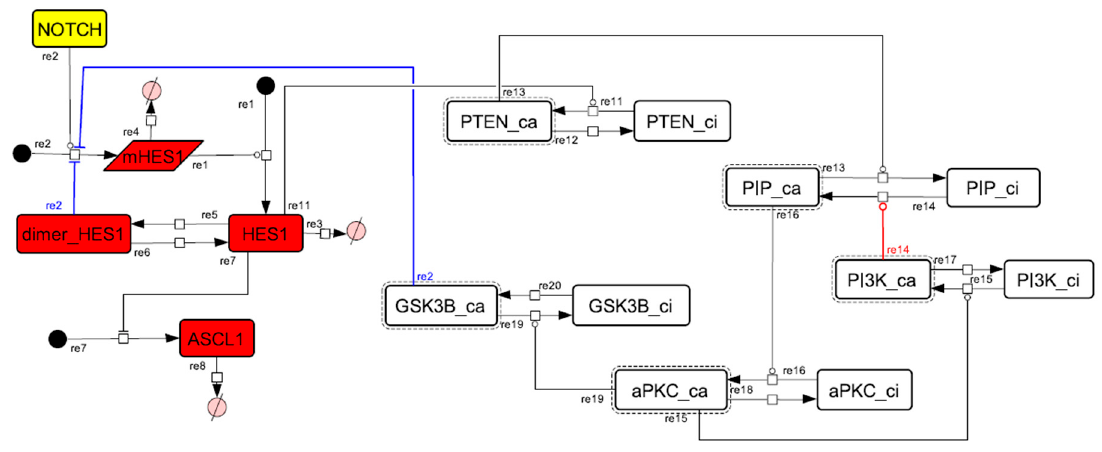
Processes 2019 , 7 , x FOR PEER REVIEW Figure A9. Diagram of the collapsed model of the negative ‐ feedback loop between GSK3B and Figure A9. Diagram of the collapsed model of the negative ‐ feedback loop between GSK3B and PTEN. PTEN. Figure A9. Diagram of the collapsed model of the negative-feedback loop between GSK3B and PTEN.